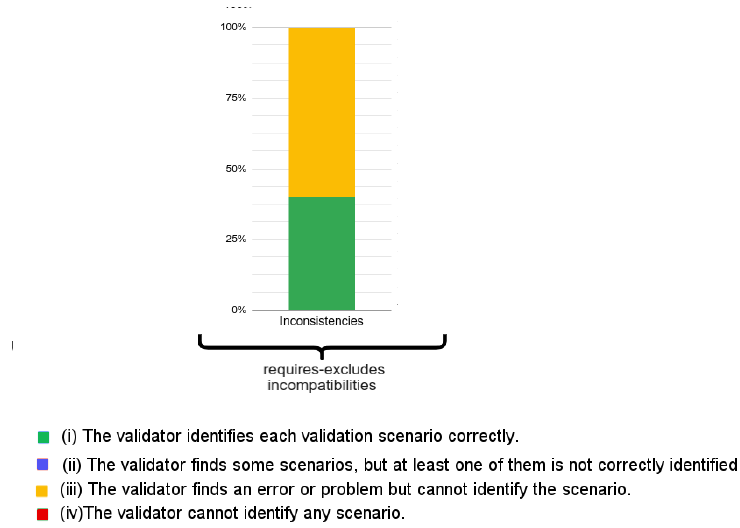
Figure 19. Results obtained by the SeVaTax